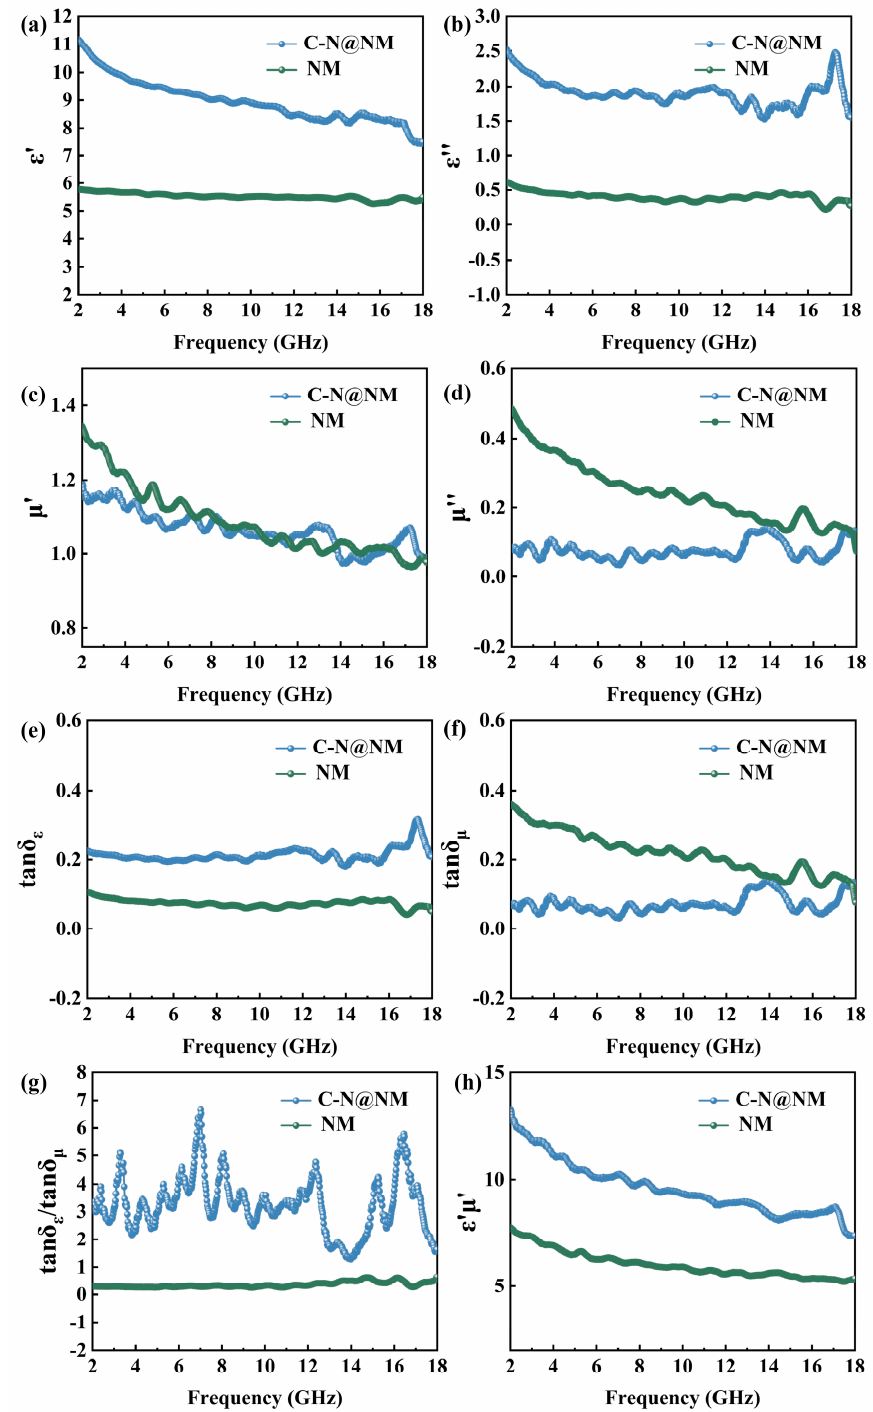
Figure 5. Electromagnetic parameters of NM and C-N@NM: ( a ) ε (cid:48) ; ( b ) ε (cid:48)(cid:48) ; ( c ) µ (cid:48) ; ( d ) µ (cid:48)(cid:48) ; ( e ) tan δε ; ( f ) tan δµ ; ( g ) tan δε /tan δµ ; ( h ) ε (cid:48) µ (cid:48) .